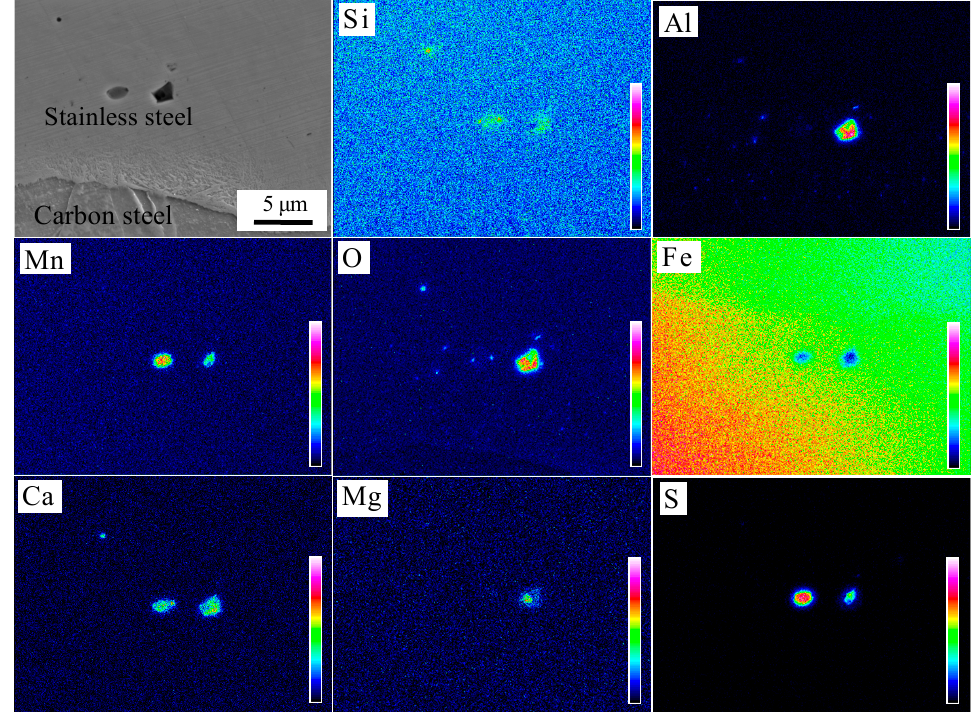
Figure 10. Distribution of elements in oxide after pickling.